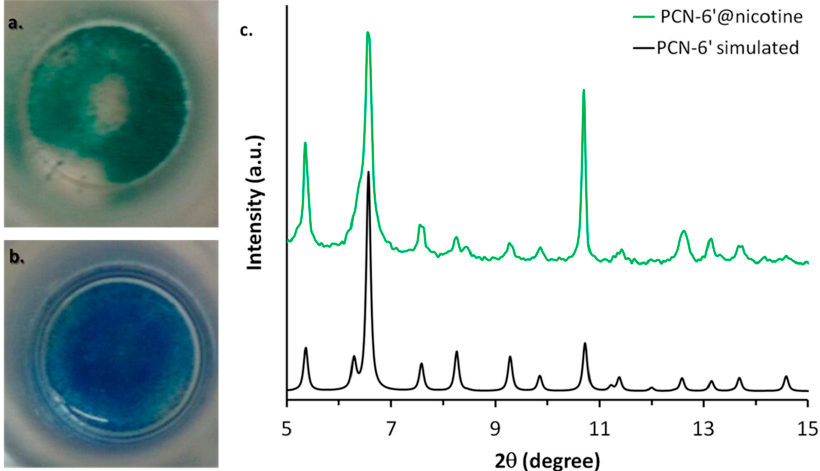
Figure 2. Colour change associated with the transformation of PCN-6 ′ @dichloromethane ( b ) into PCN-6 ′ @nicotine ( a ). ( c ) The comparison between the calculated XRPD trace of PCN-6 ′ (black) and the experimental one collected with PCN-6 ′ @nicotine (green).